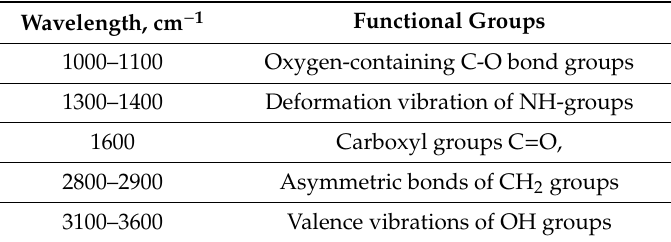
Figure 4. IR spectra of C. sorokiniana biomass. Table 1. Spectral characteristic of C. sorokiniana biomass [59].